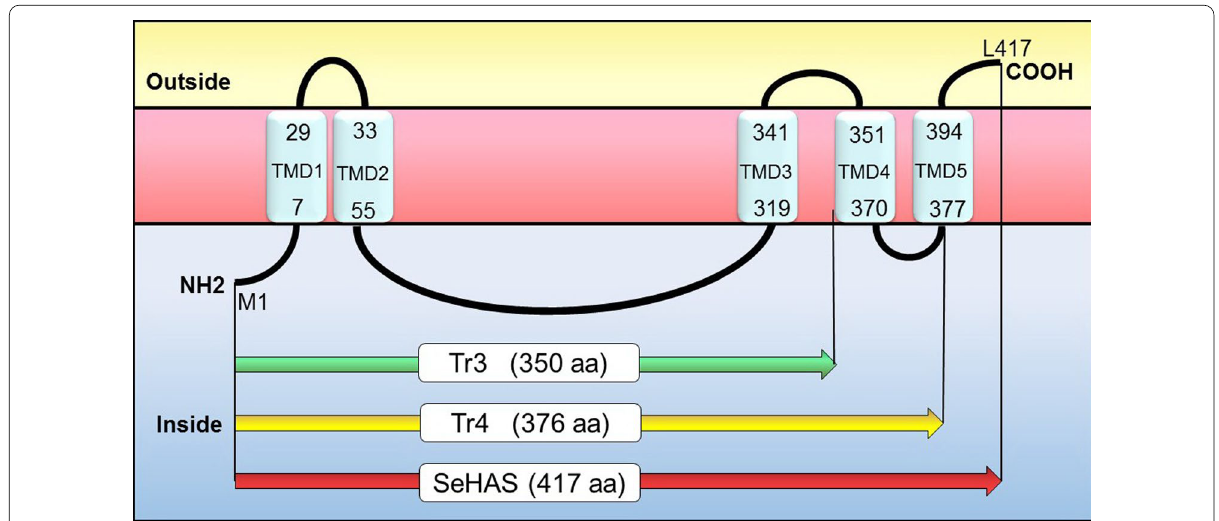
Fig. 1 Topological model of seHAS in the membrane. The numbers within each TMD indicates its starting and ending residues